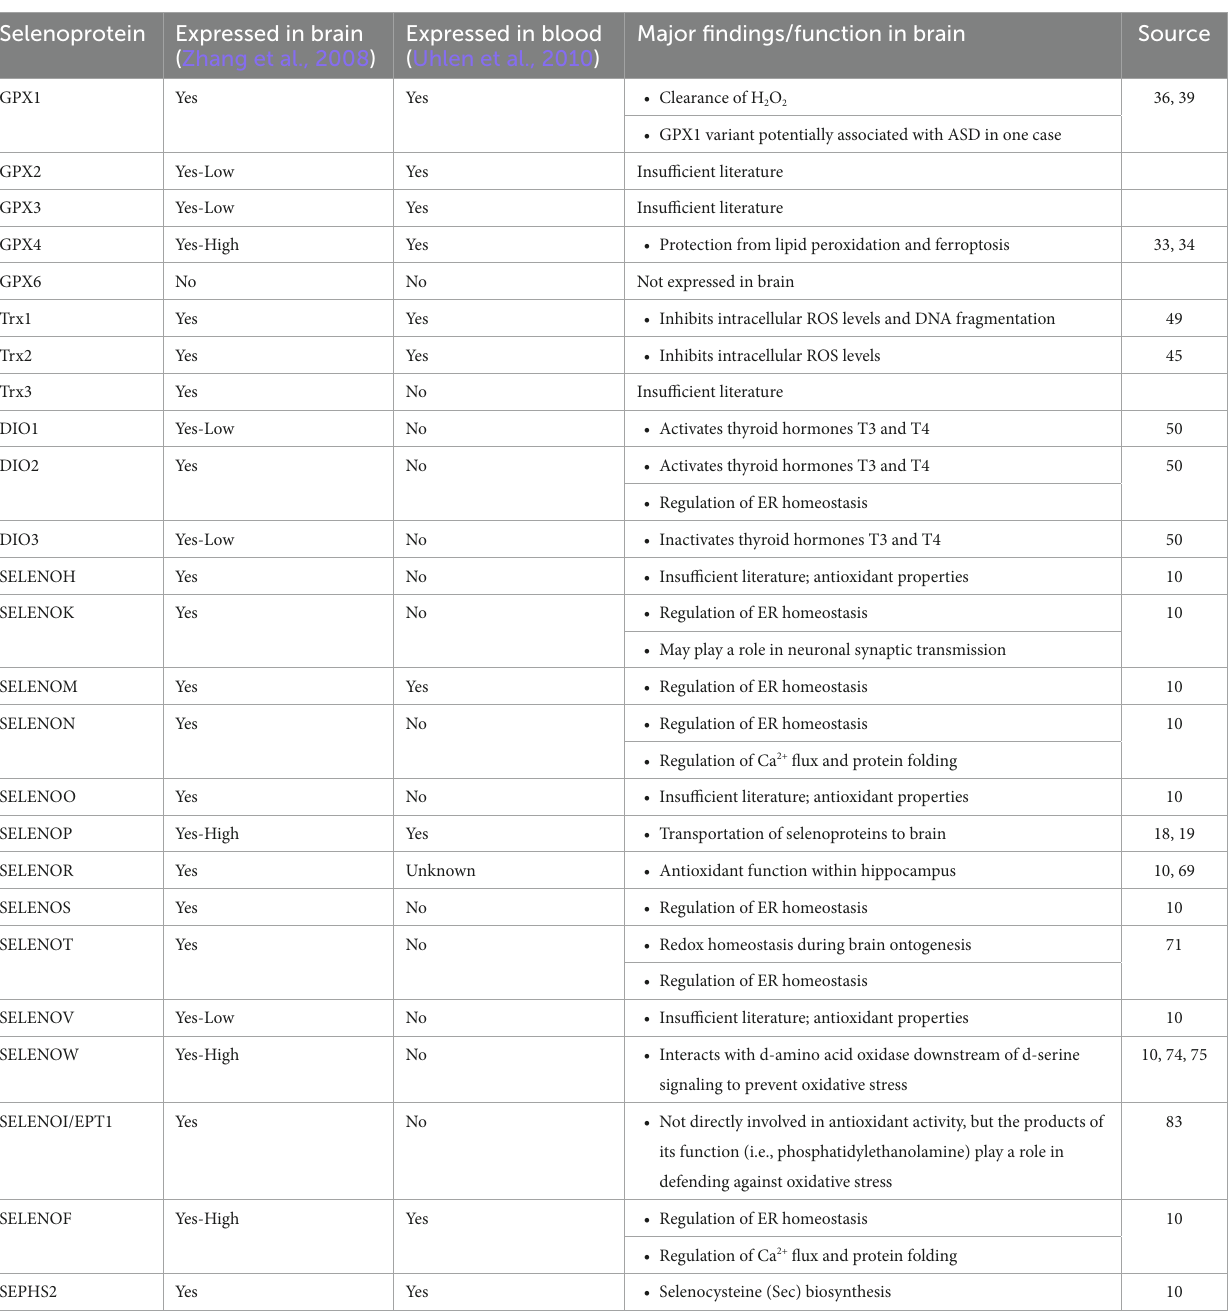
TABLE 1 Twenty-Five selenoproteins along with expression in brain and blood and major functions in brain. Selenoprotein Expressed in brain Expressed in blood Major findings/function in (Zhang et al., 2008) (Uhlen et al., 2010)